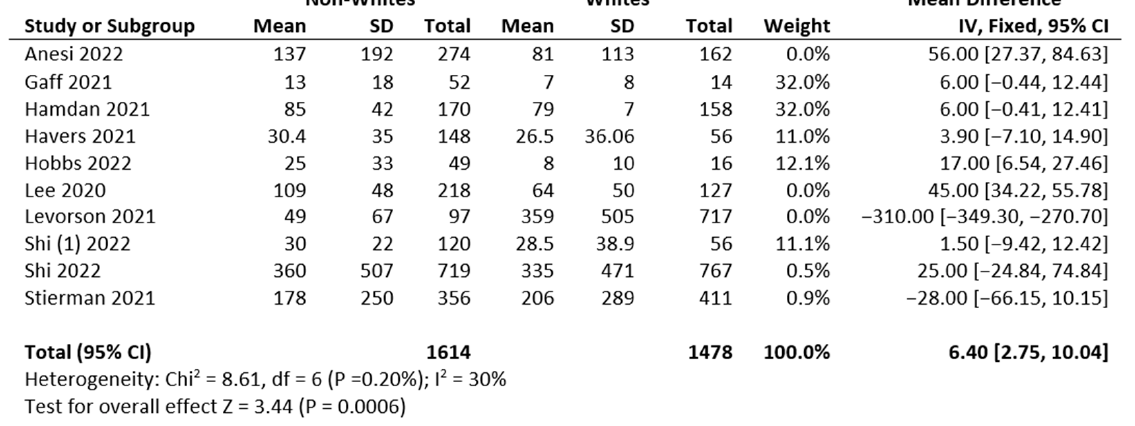
Figure 3. Mean, standard deviation, and heterogeneity of reviewed studies [15–19,21,23,25,26,33].